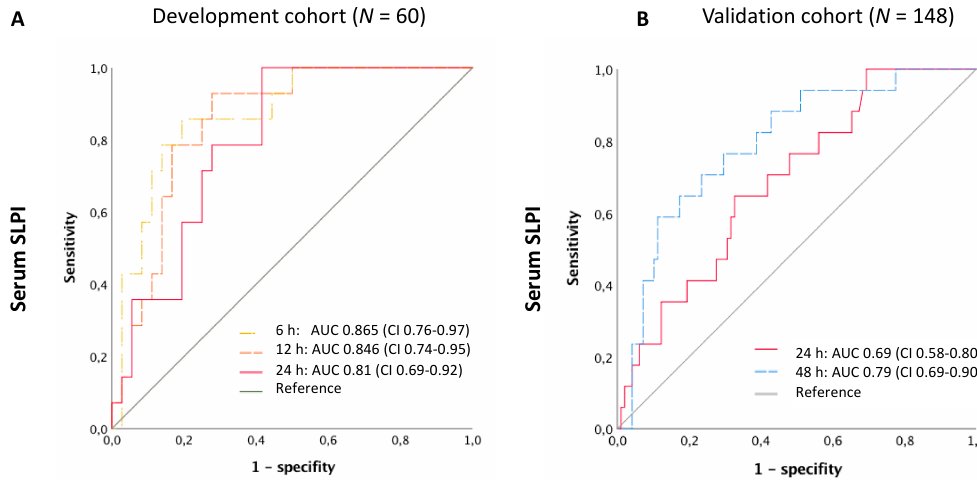
Figure 4. Receiver operating characteristic (ROC) curves of SLPI and NGAL for the diagnosis of AKI at different time points after surgery. ( A ) ROC of serum SLPI in the development study and ( B ) in the validation study. AKI, acute kidney injury; AUC, area under the curve; CI, 95% confidence interval; SLPI, secretory leukocyte protease inhibitor.